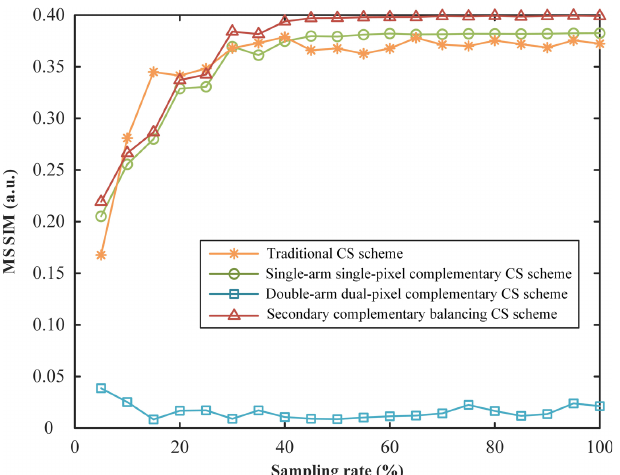
Figure 7. Curves of MSSIM values of a traditional CS scheme, single-arm single-pixel complemen- tary CS scheme, double-arm dual-pixel complementary CS scheme and secondary complementary balancing CS scheme as a function of the sampling